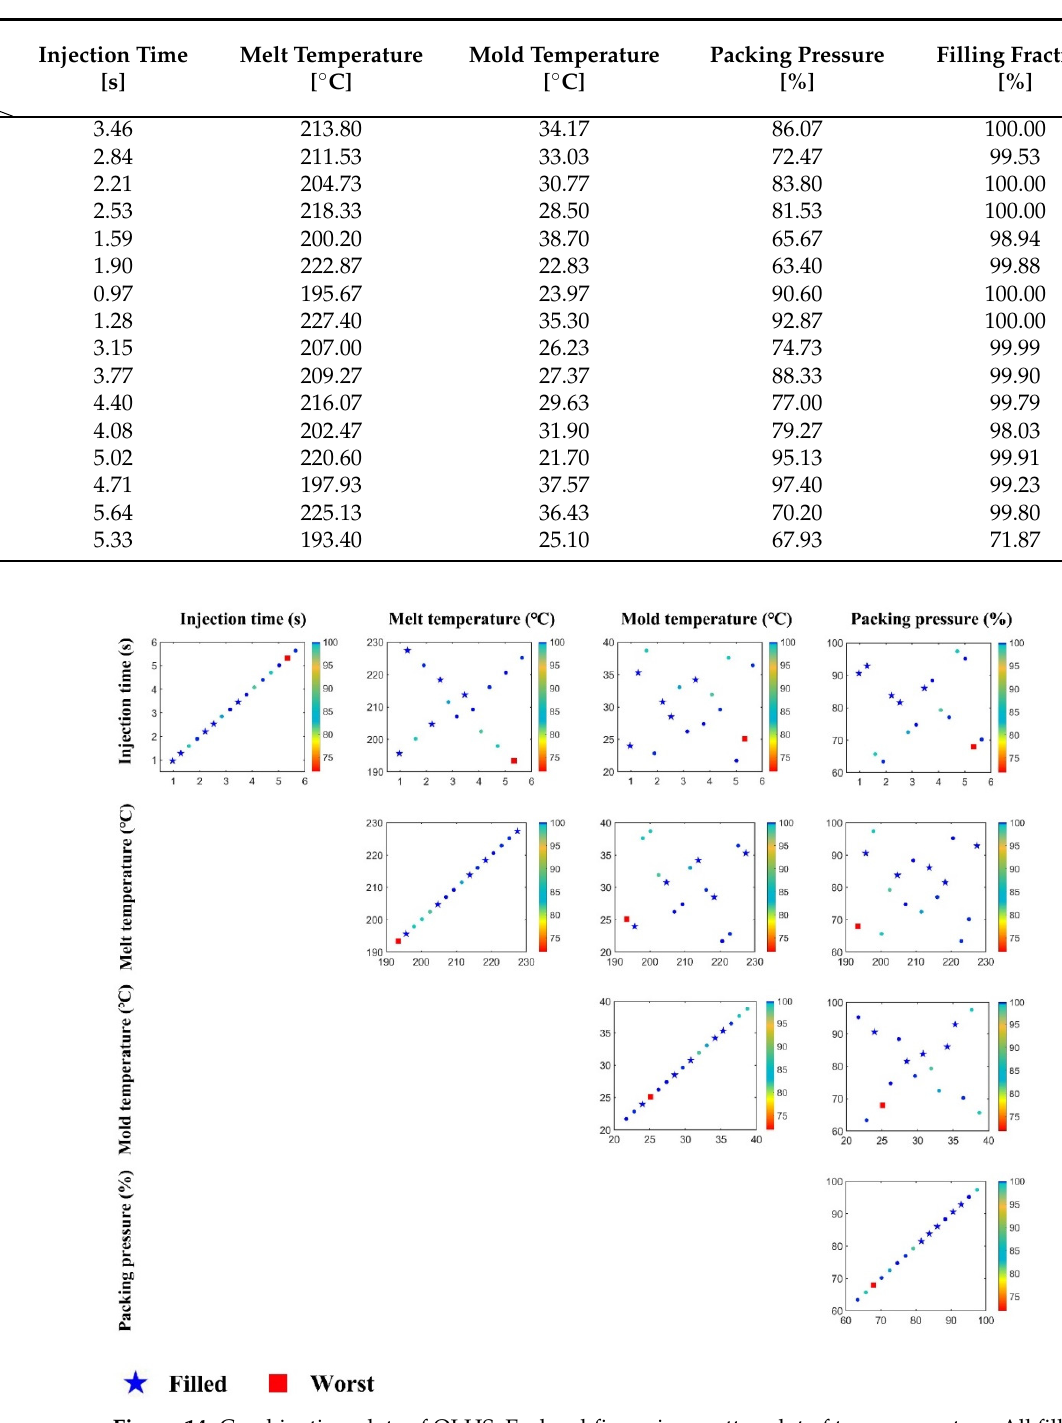
Table 9. Processing parameters of the packing pressure study, according to [33].